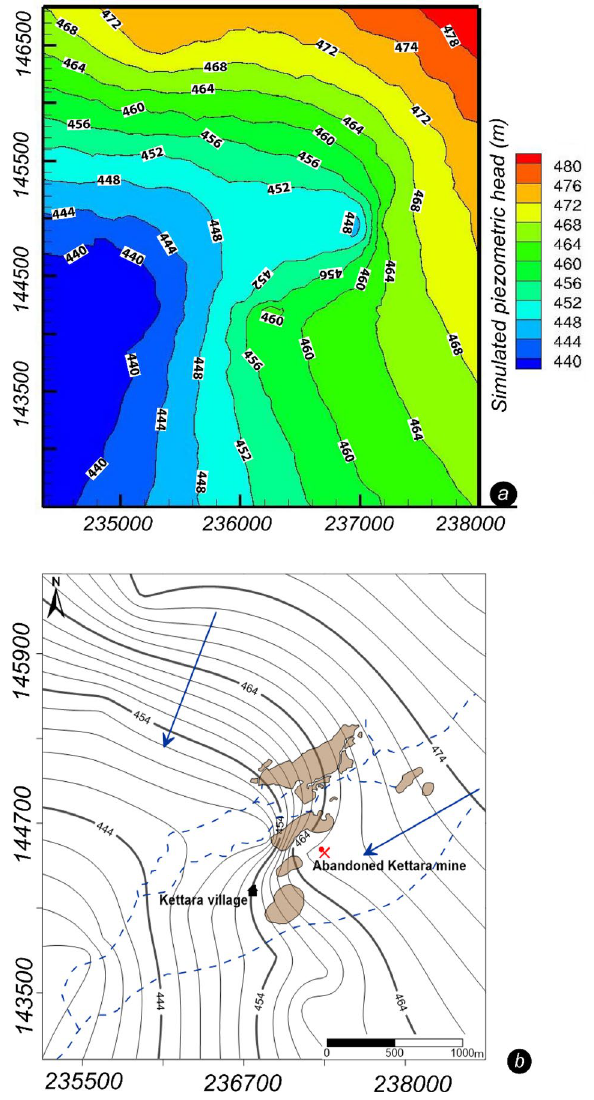
Fig. 3 Comparison of the computed and measured piezometric head: a computed values by the control volume finite element method (CVFEM), b measured